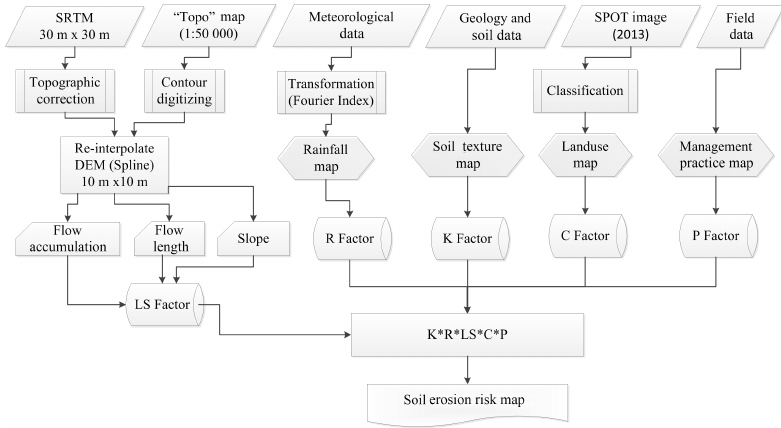
Figure 2. Conceptual framework of the research methodology to estimate the soil erosion rate using the RUSLE model.